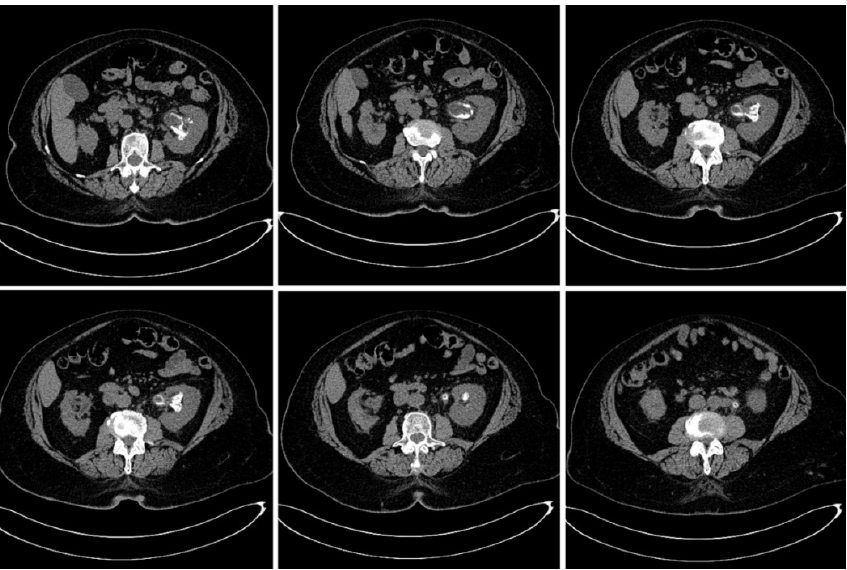
Figure 1. Axial plane images of abdominal and pelvic CT scan without contrast showing multiple pyelic, calyceal, and ureteral calcifications specific to encrusted uretero-pyelitis. Based on the imaging and laboratory findings, the diagnosis established in the Depart- ment of Urology (together with the nephrologist) was of encrusted uretero-pyelitis with obstructive nephropathy and acute kidney injury AKIN 3/CKD G5, CKD-MBD (mineral bone disease) (iPTH = 205.6 pg/mL, serum phosphate = 5.5